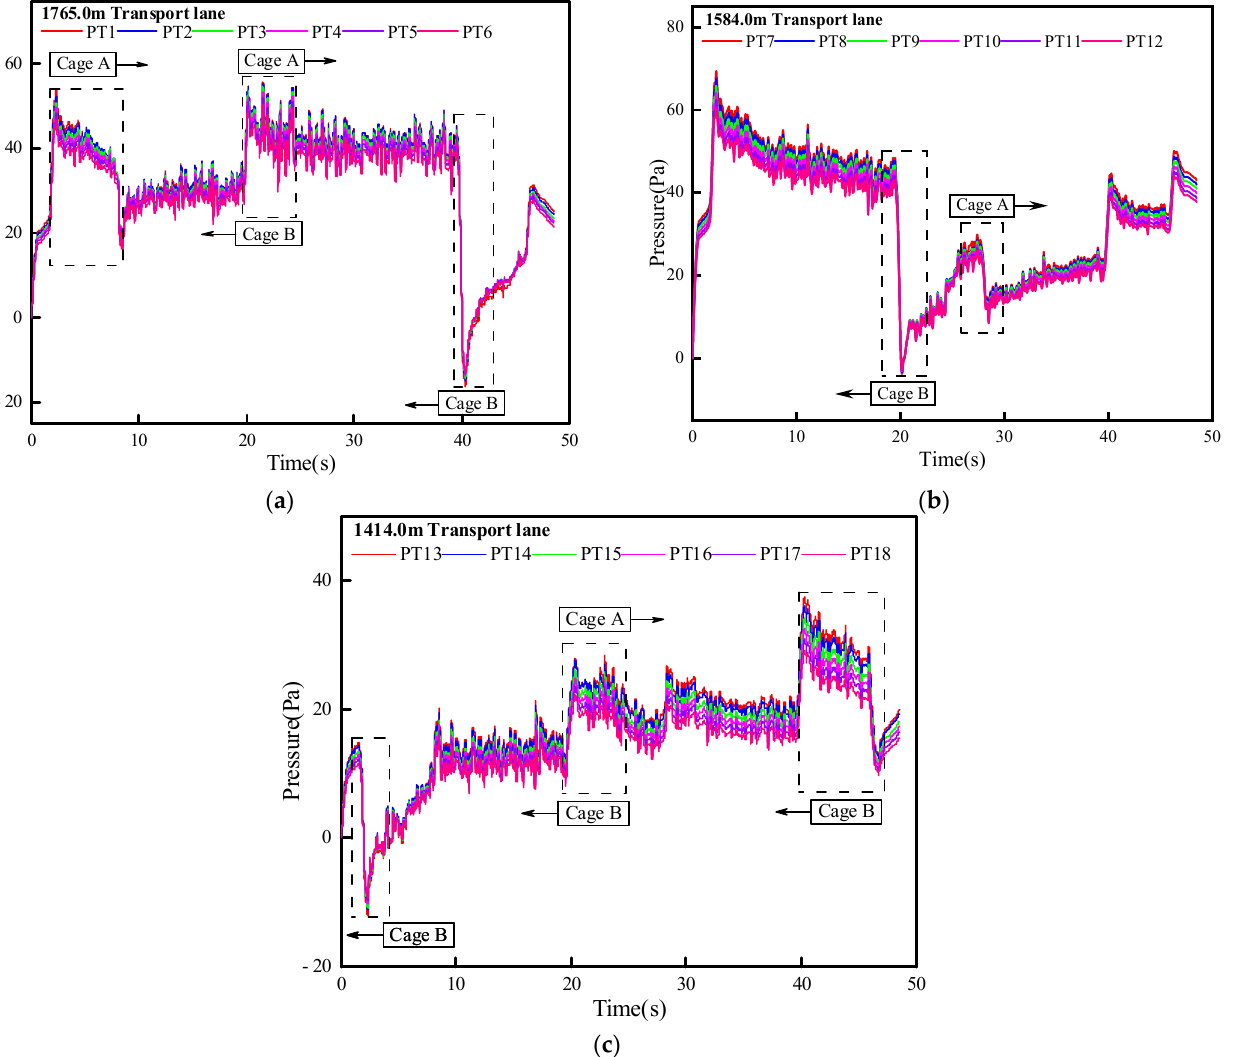
Figure 12. The time-varying curve of pressure at each measuring point in different transport lanes: ( a ) 1765.0 m transport lane, ( b ) 1584.0 m transport lane, ( c ) 1414.0 m transport lane. Figure 13 shows the difference between the maximum and minimum pressure caused by the piston effect in each transport lane. From the figure, we can see that the pressure difference of each measuring point is linearly decreasing with the distance from the measuring point to the shaft. That is, the farther away from the shaft measuring point, the less affected by the piston effect, and the smaller the pressure difference. The measur- ing point distance increased from 21.7 m to 71.7 m, and the pressure in 1414.0 m, 1584.0 m and 1765.0 m transport lanes decreased by 11.08 Pa, 9.62 Pa and 8.58 Pa, respectively.